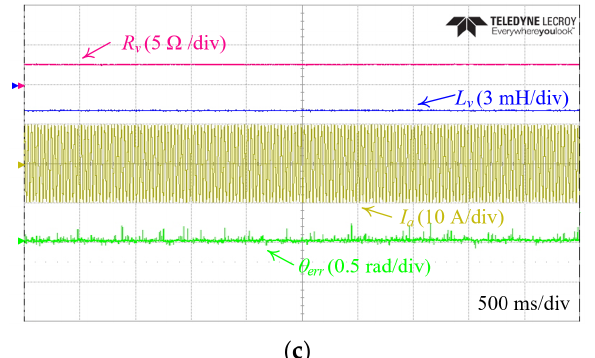
Figure 18. Experimental results of the proposed flying start method and its position estimation error at 1000 rpm. ( a )   ,   , I a , and   ; ( b ) magnified waveform of ( a ); and ( c ) the steady state of the proposed flying start method.